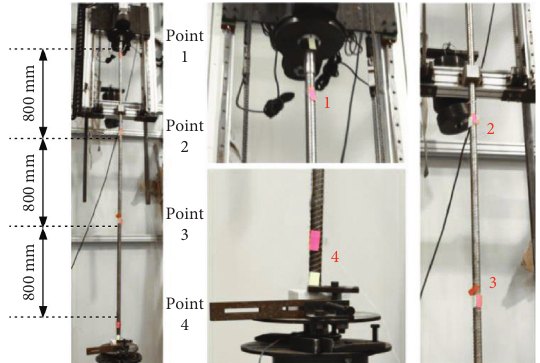
Figure 10: The layout of the fiber Bragg grating in the impact stress transmission test.